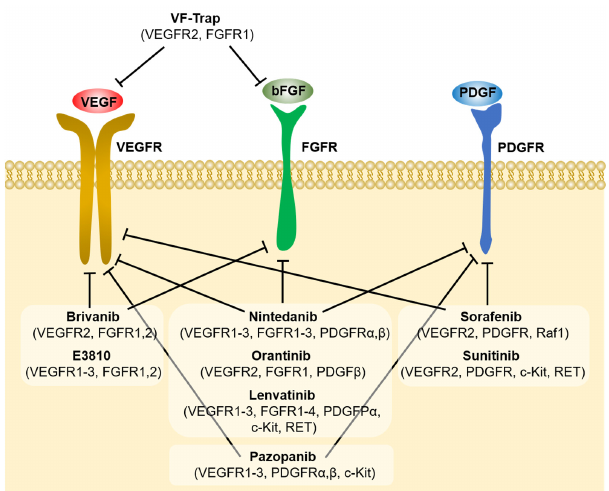
Figure 2. Inhibitors targeting combination of angiogenesis pathways either blocking ligand interaction (VF-Trap) or downstream signaling pathways. The parenthesis below each inhibitor highlight the growth factor receptors targeted by each inhibitor.